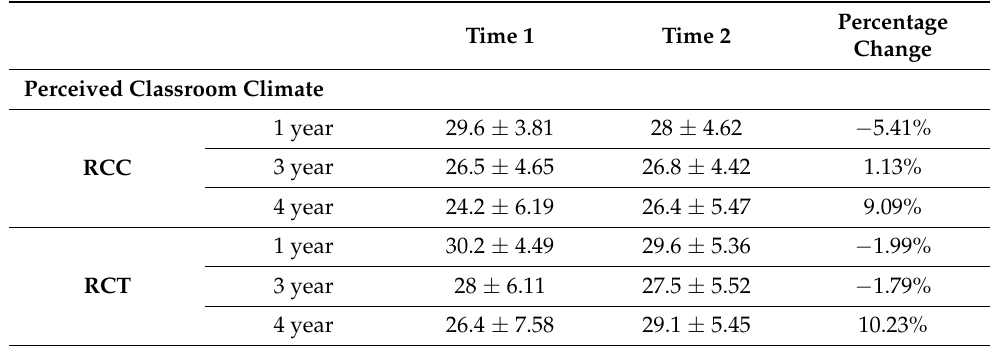
Table 7. Differences in perceived classroom climate in Time 1 (before lockdown declaration) and Time 2 (after lockdown) based on Year of